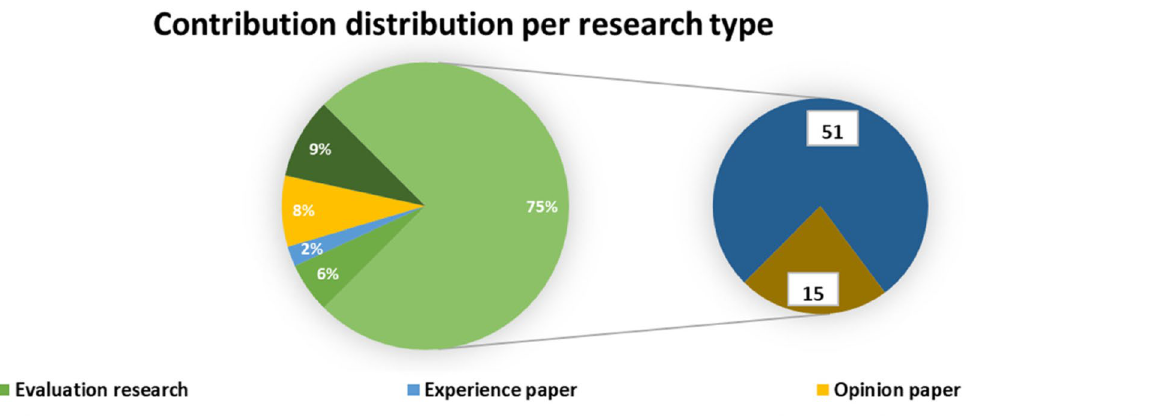
Fig. 10 Publication distribution per research type